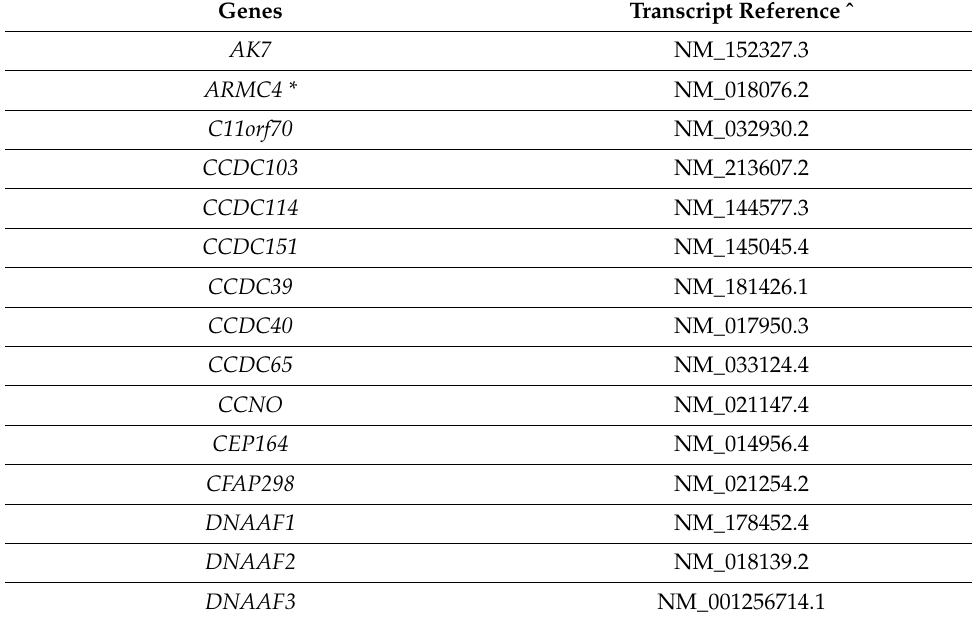
Table A1. Complete list of genes and PCD genes transcripts analyzed in our